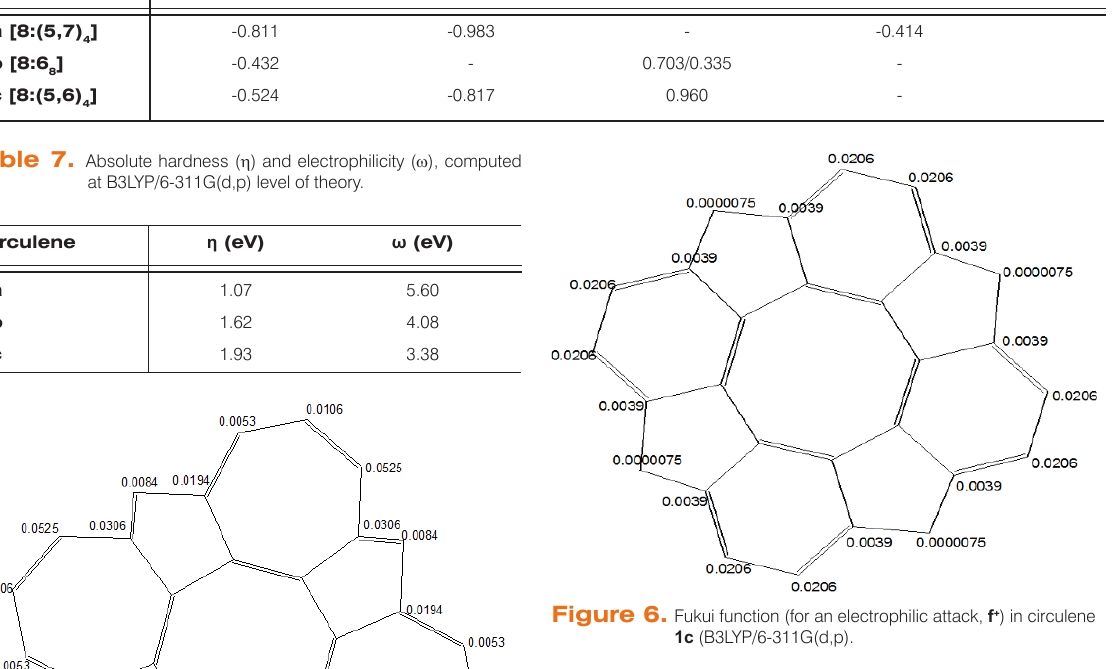
Table 6. HOMA values, computed for the circulenes 1a to 1c (HF/6-311G(d,p) level of theory). Circulene